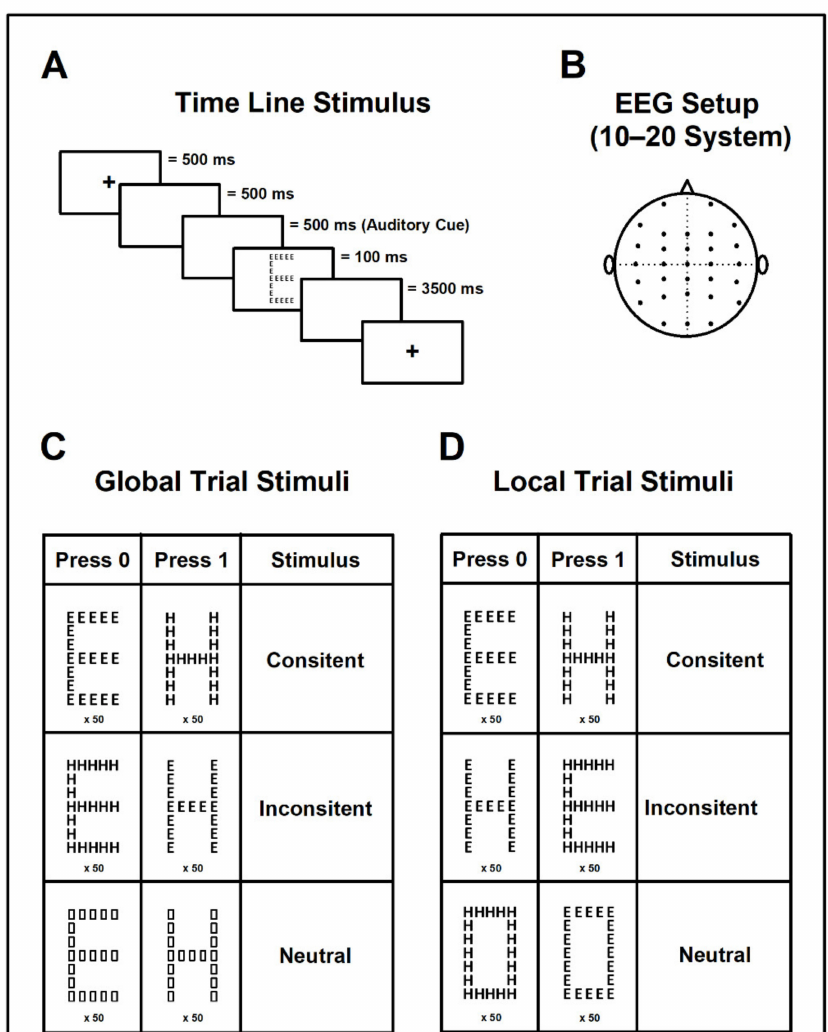
Figure 1. Hierarchical Visuospatial Aspect Recognition paradigm coupled with EEG. ( A ) The order and timing at which stimulus was presented were coupled with the EEG to create a window large enough for the collection of coherence data during visual object processing. ( B ) The placement of the electrodes on the scalp followed the international 10–20 system to assure